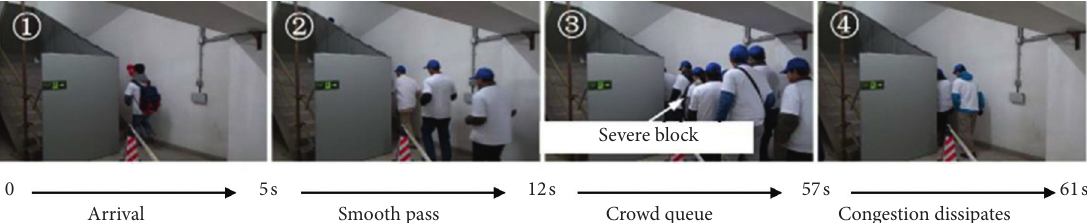
Figure 10: Changing process of crowd flow in front of escape staircase.